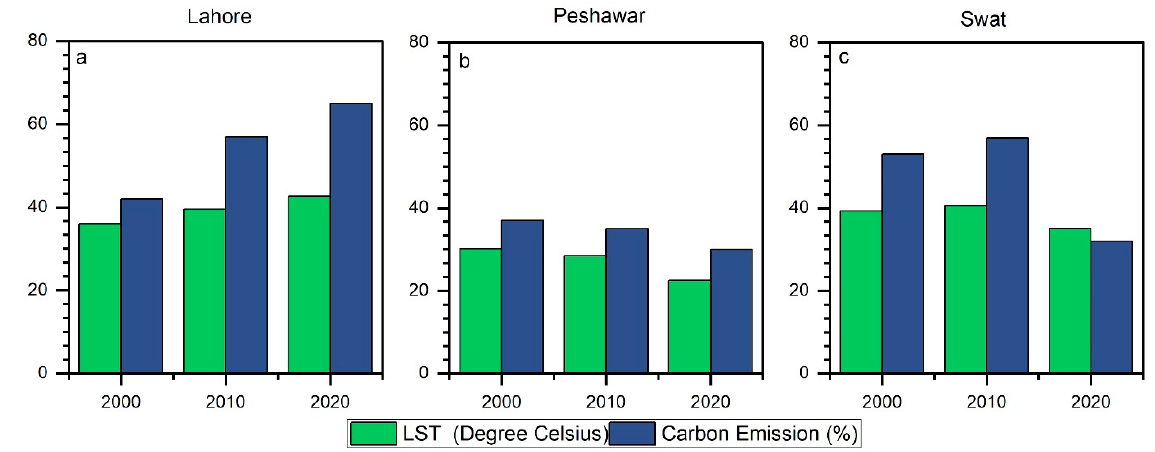
Figure 10. Sensitivity analysis between LST and carbon emission.